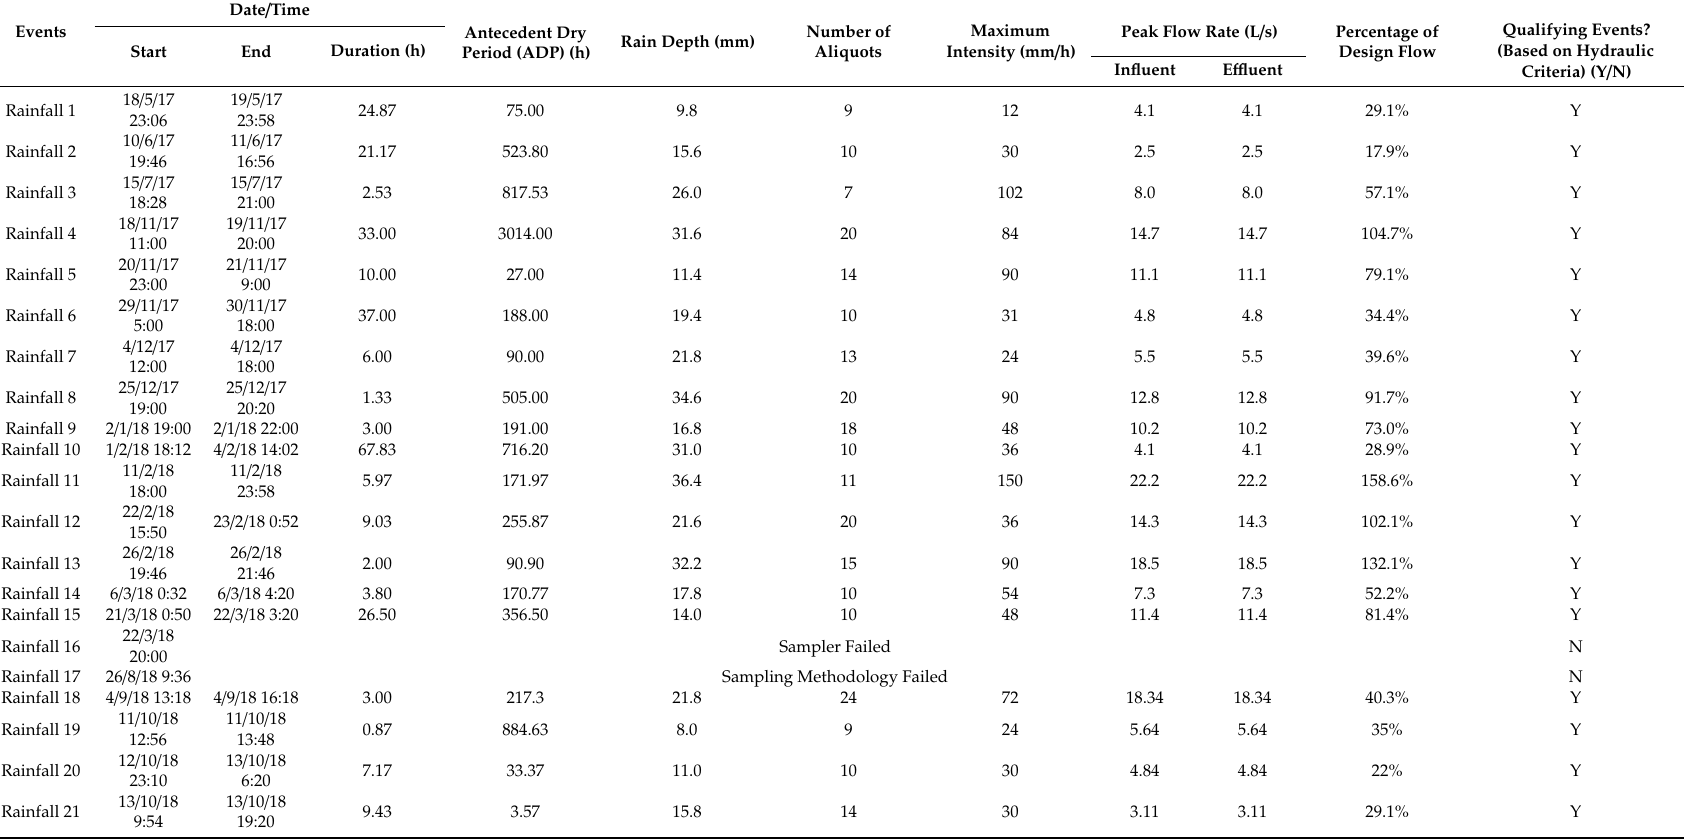
Table A1. Details of all Events during the field